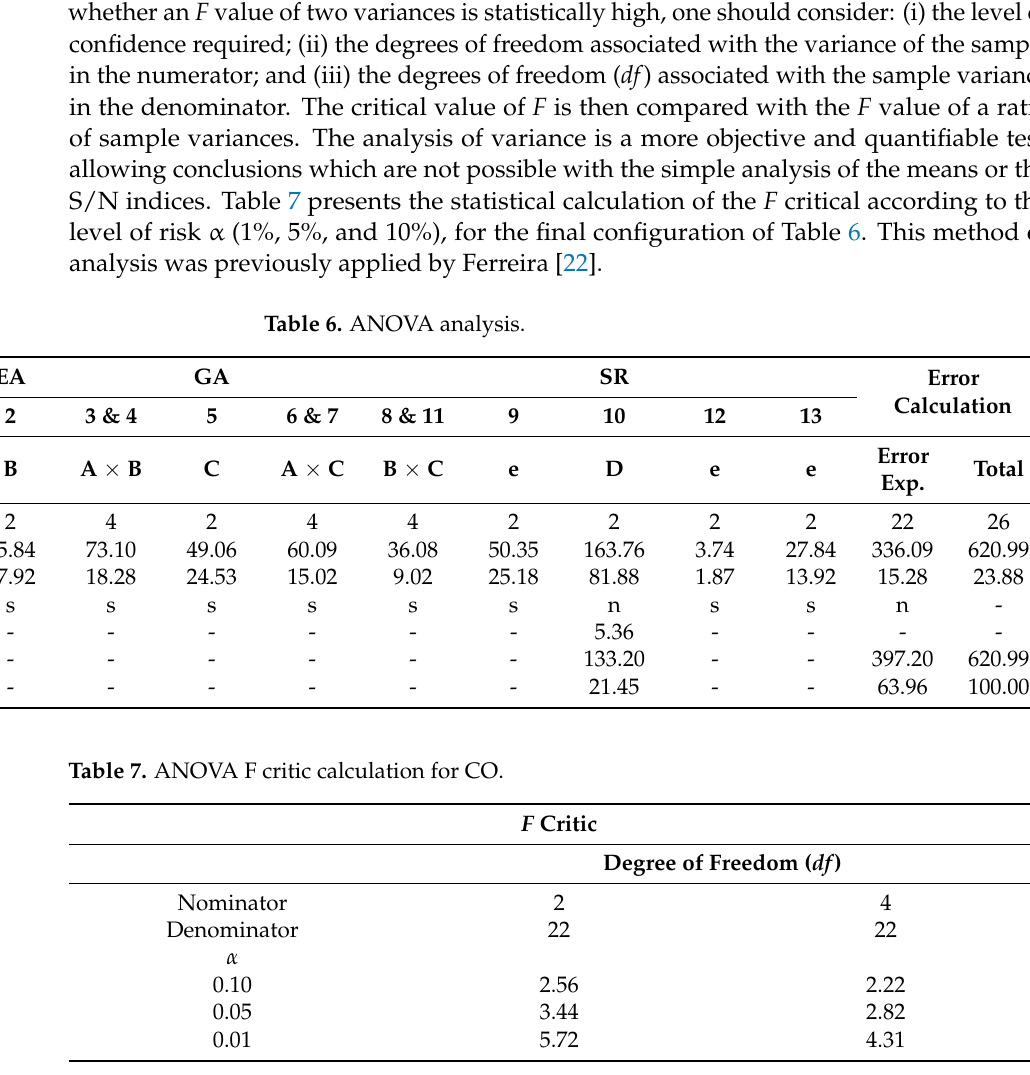
Figure 7. Indices of interaction between factors on CO S/N values for: ( a ) each EA level at different power levels; ( b ) each GA level at different power levels.